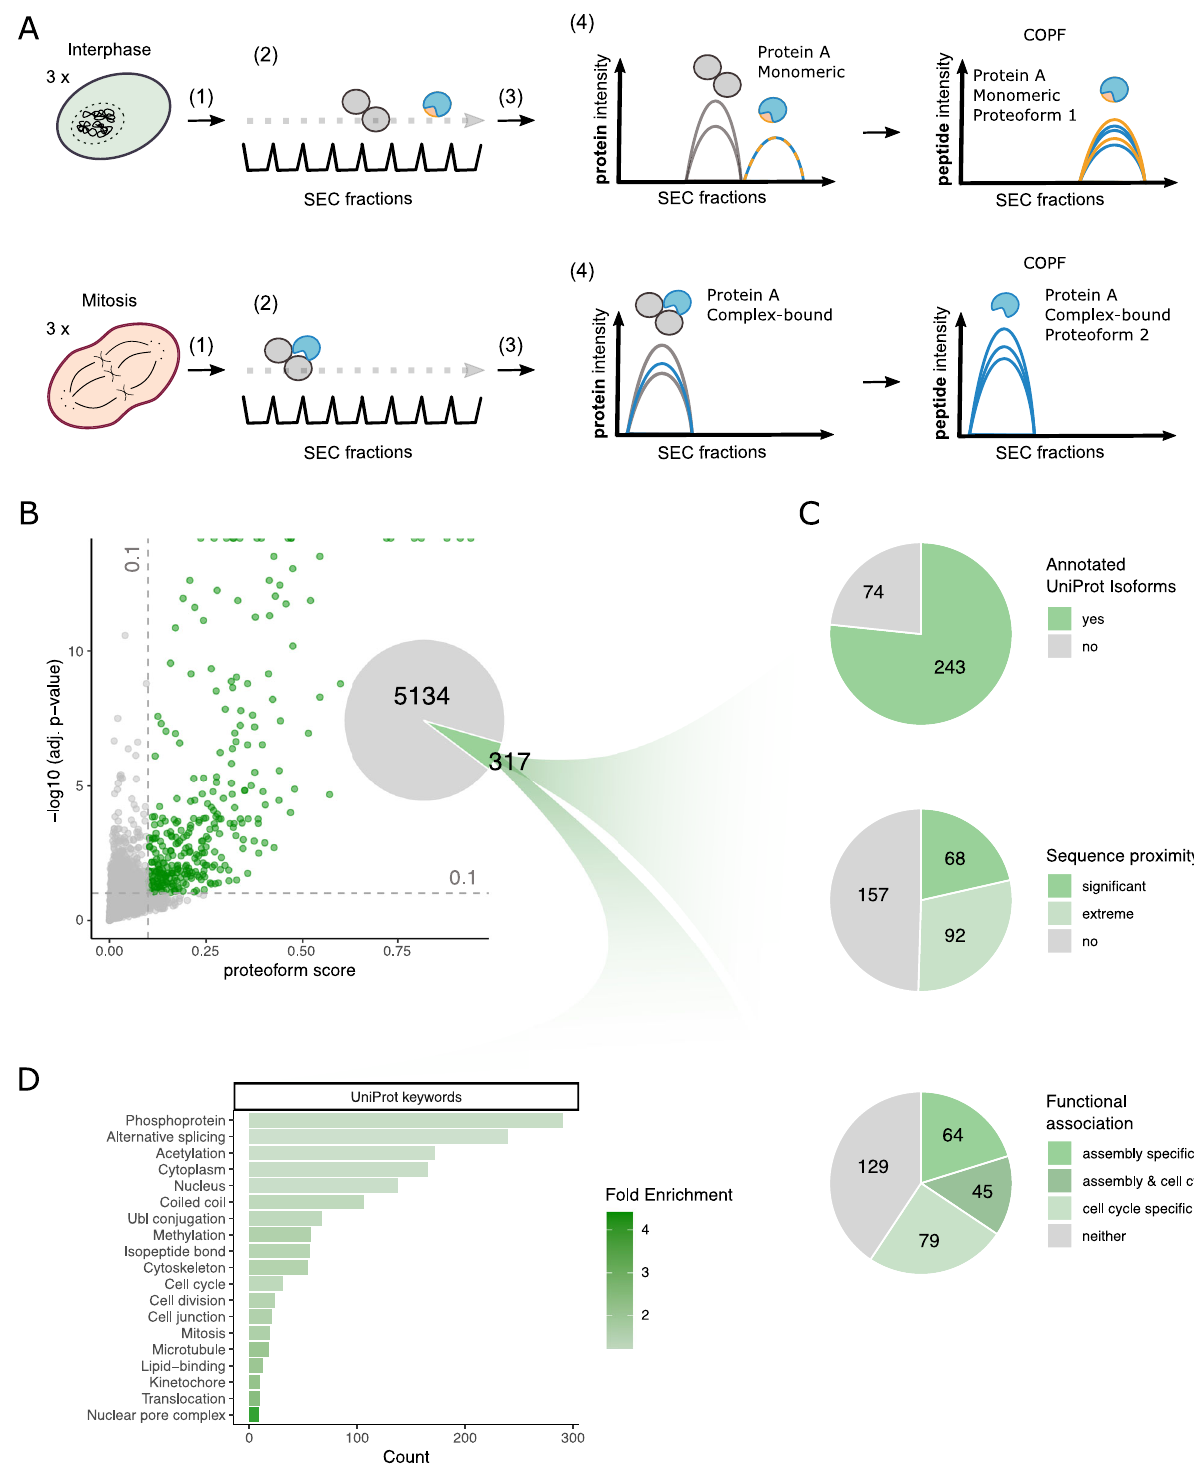
Fig. 3 Global insights into cell cycle- and assembly-speci fi c proteoforms in SEC-SWATH-MS data. A Schematic overview of the experimental design and SEC-SWATH-MS analysis work fl ow. HeLa cells were blocked in either interphase or mitosis. Samples were subject to mild cell lysis (1) followed by protein complex fractionation via SEC (2). Each of the consecutively sampled fractions was separately subjected to a bottom-up proteomic work fl ow including tryptic digestion and MS data acquisition by SWATH-MS (3). The resulting protein- and peptide-level quantitative pro fi les along the SEC dimension were used for protein complex assessment and proteoform analysis with COPF (4). B Pseudo-volcano plot showing the proteoform scoring results for the cell cycle SEC-SWATH-MS dataset. At a multiple-testing corrected p -value threshold of 10% and minimal proteoform score of 0.1, a set of 317 proteins was predicted by the algorithm to contain multiple proteoform groups. C Assessment of the reported proteoform groups. D UniProt keyword enrichment analysis of the predicted set of reported proteoform